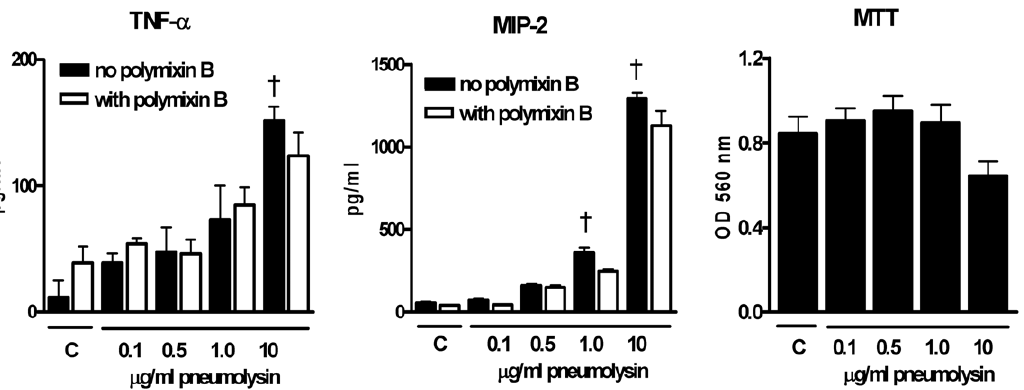
Figure 2. Inflammatory and cytolytic effects of PLN on mouse alveolar macrophage MH-S cells. MH-S cells were incubated with increasing doses of PLN for 6 hours with/without polymyxin B (10 m g/ml ) and TNF- a , MIP-2 and cell death were determined thereafter. Cell death was measured using MTT assay as described in Methods section. Data are mean 6 SEM (N=5 per group). * P , 0.05, { P , 0.01 versus control.